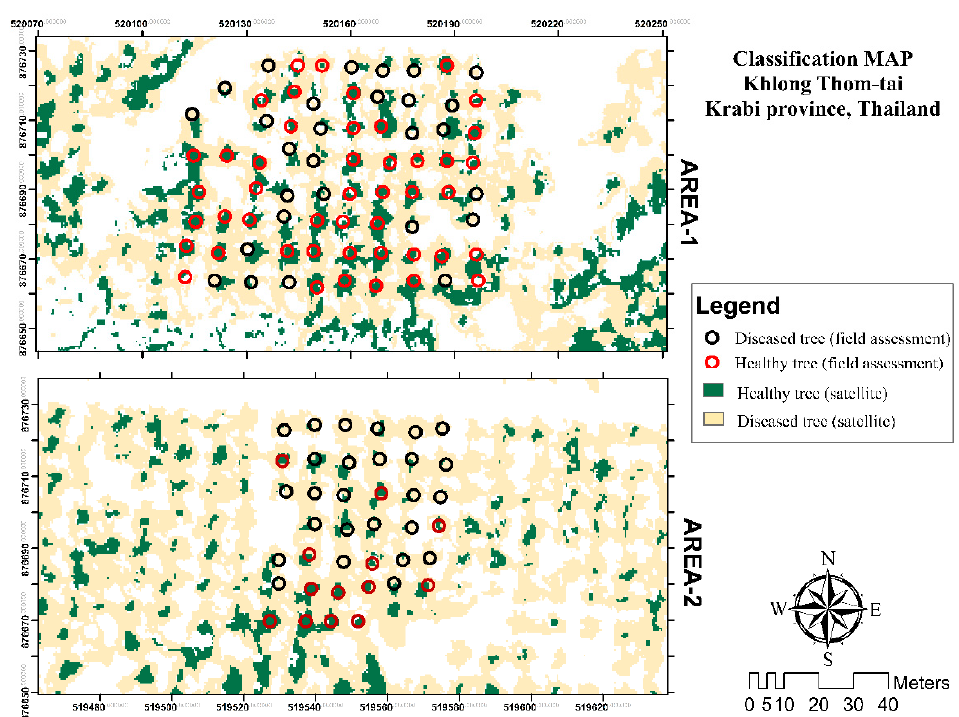
Figure 10. Thematic map of the maximum likelihood supervised classification result.